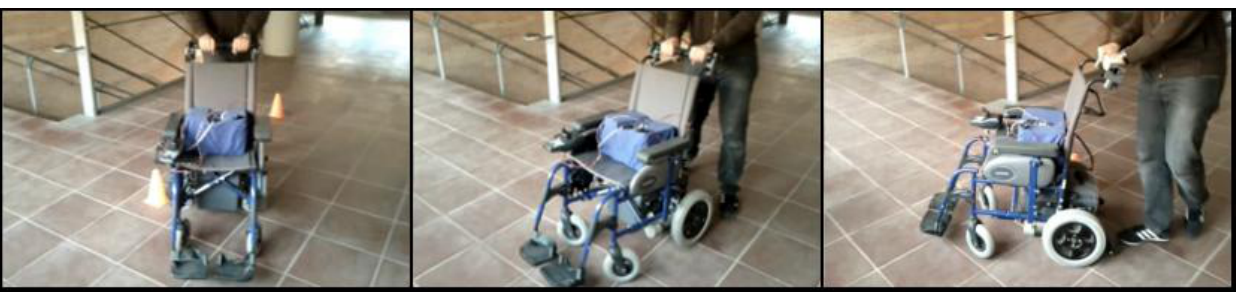
Figure 17. Sequence of pictures to illustrate a turn to the right.